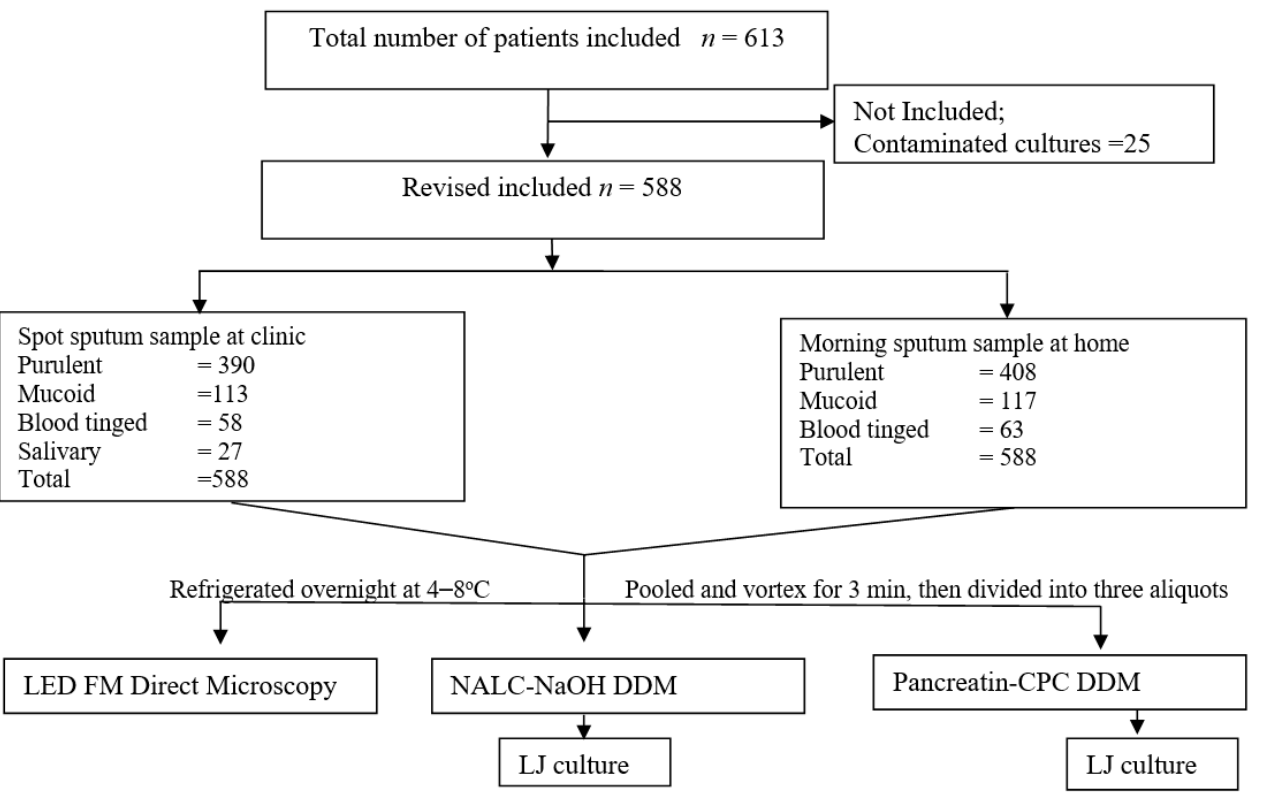
Figure 1. Flow chart showing study profile. Table 1. Overall results (direct microscopy and culture results) were obtained after digestion and decontamination with